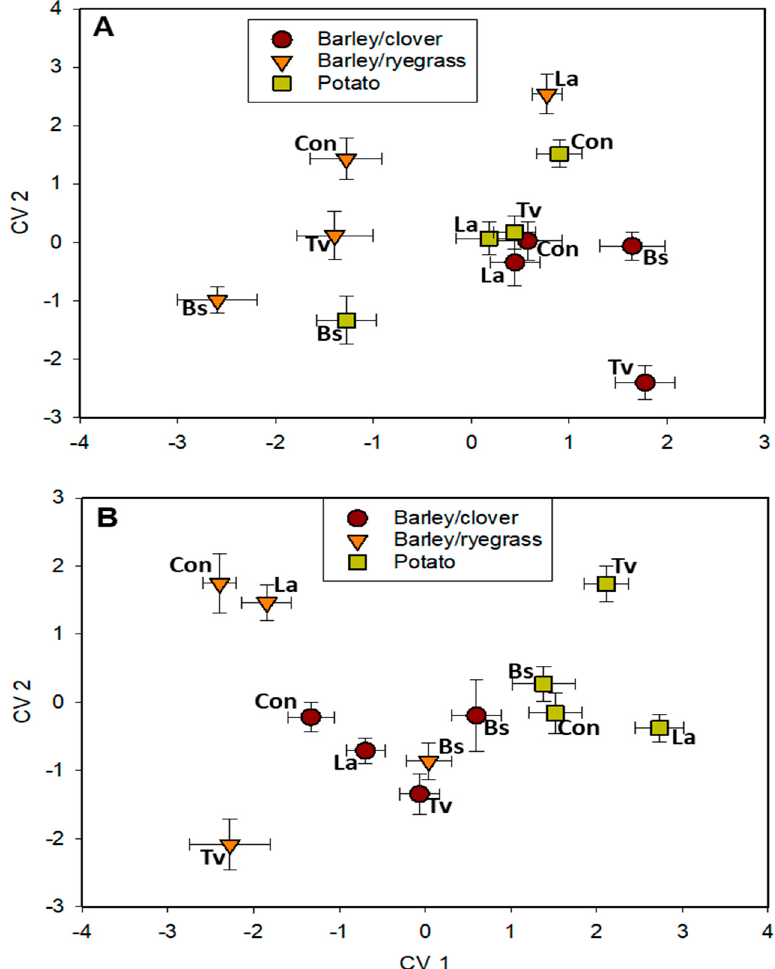
Figure 4. Effects of preceding rotation crop and biocontrol treatments on soil FAME profiles as represented by canonical variates (CV) 1 and 2 from canonical variates analysis from soils sampled in August of year 2 at ( A ) location 1 (Central Maine) and ( B ) location 2 (Northen Maine). Error bars represent the standard error of the mean for each CV. Biocontrol treatments represented by: Bs = B. subtilis ; La = L. arvalis ; Tv = T.virens ; Con = nontreated control.